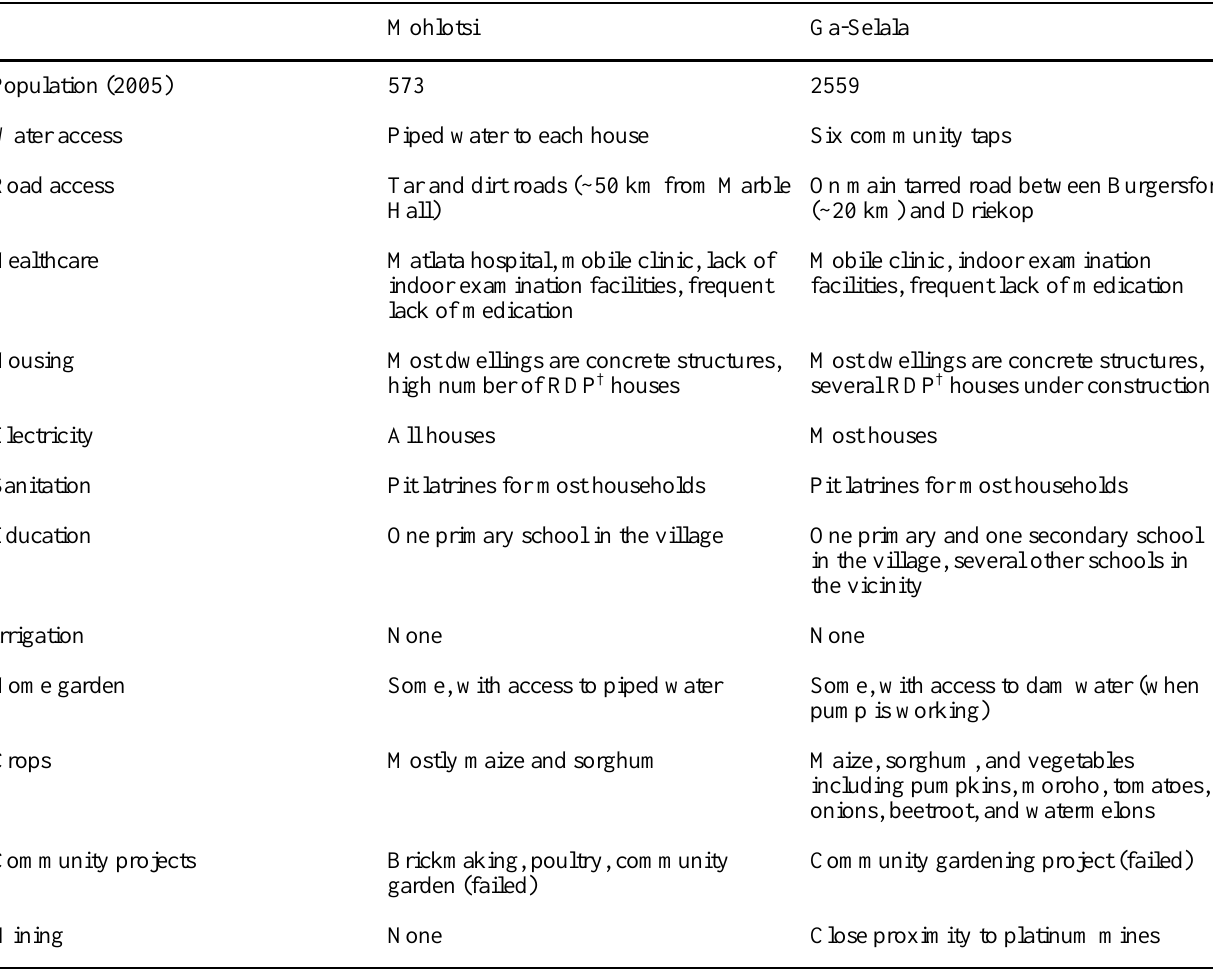
Table 3. Village profiles of Mohlotsi and Ga-Selala, February